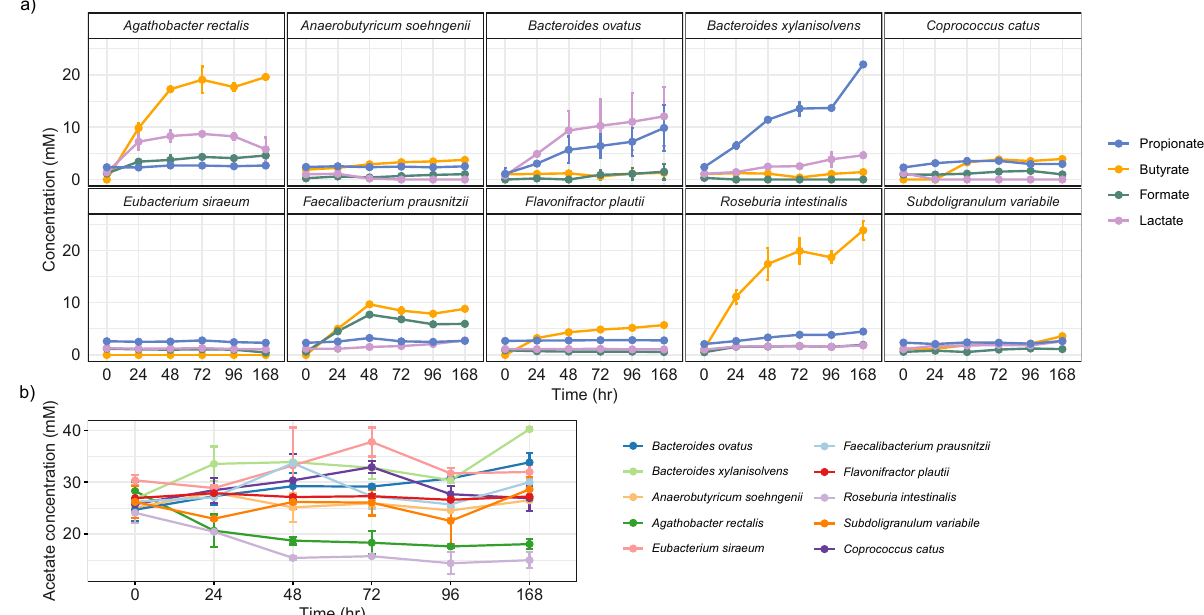
Fig. 3 Metabolite analysis of Db-MM strains grown in monocultures. a Metabolites produced/consumed by Db-MM strains as monocultures grown in combination of xylan (beechwood), starch (from potato), inulin (from chicory), pectin (from apple), and cellobiose. b Changes in the concentration of acetate that was added at ~30 mM to support growth. Error bars indicate average measurements from duplicate cultures. The error bars represent standard deviation values for replicates at each time